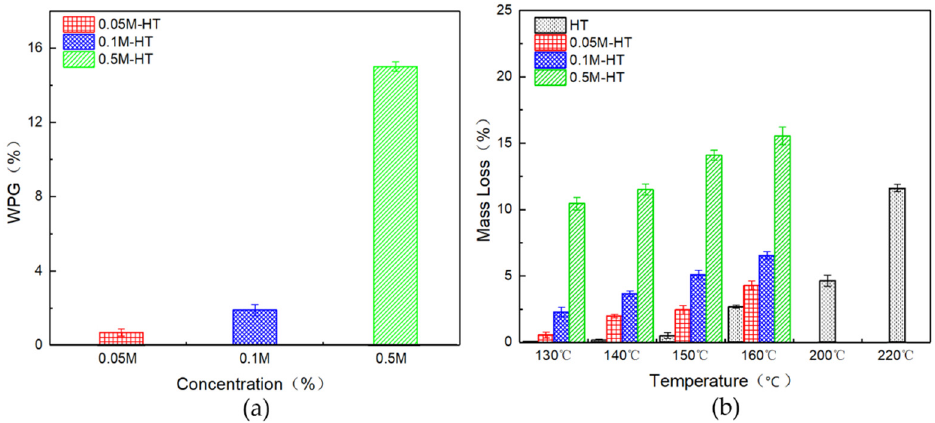
Figure 1. ( a ) WPG of samples and ( b ) ML of samples for different treatment conditions.